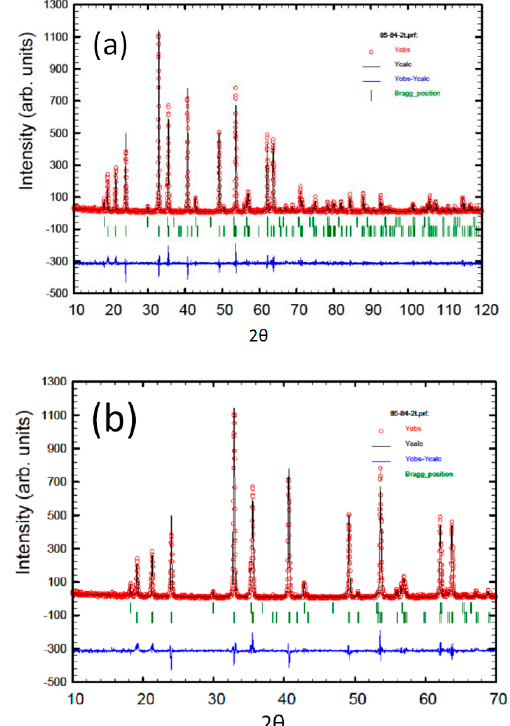
Figure 1. ( a ) Rietveld diagram (FullProf) of sample GQ after 5 h annealing at 1200 °C and scanned in a Rigaku diffractometer at room temperature (whole 2 θ range). ( b ) Rietveld diagram (FullProf) of sample GQ after 5 h annealing at 1200 °C and scanned in Rigaku diffractometer at room temperature (small 2 θ range) .